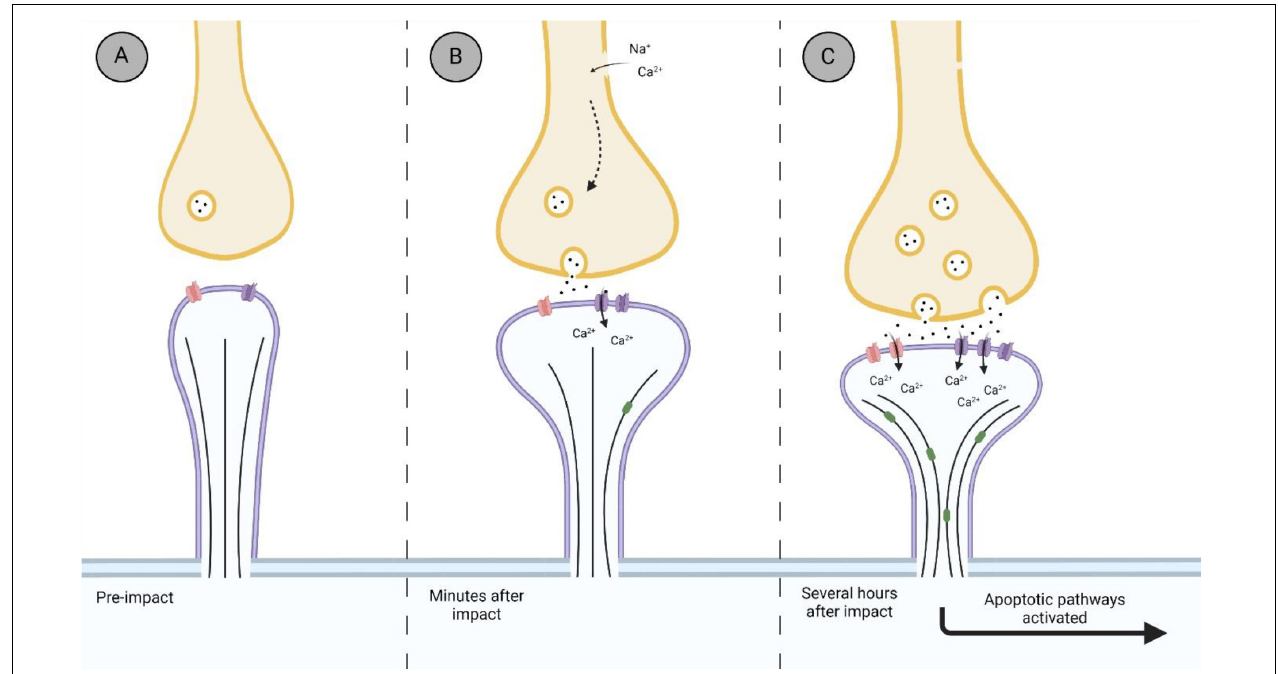
FIGURE 4 | Representation of the biological timeline of the synapse after impact. (A) Thin synapse before an impact. Thin spines are considered a transitory spine phenotype, with the potential to transition in an excitatory synapse. (B) Within minutes after impact, synaptic changes within the hyperacute phase after impact. Membrane ruptures and ionic imbalances promote the hyperexcitability of the synapse, with an influx of Ca 2 + into the post-synaptic terminal via NMDAr (purple). (C) Further damage to the synapse due to hyperexcitability and sustained release of glutamate from the pre-synaptic terminal is observed several hours after impact. Increased influx of Ca 2 + into the post-synaptic terminal promotes the further upregulation of NMDAr, as well as upregulating GluR1 subunit of AMPAr (red). Disinhibition of synaptic reconstruction proteins, such as EB3 (green), occurs as restricting proteins become inactivated, promoting excitatory mushroom spine phenotype. Hyperexcitability promotes neurodegenerative pathways via overworked mitochondria and damage to the microtubule cytoskeleton of the neuron. Created with